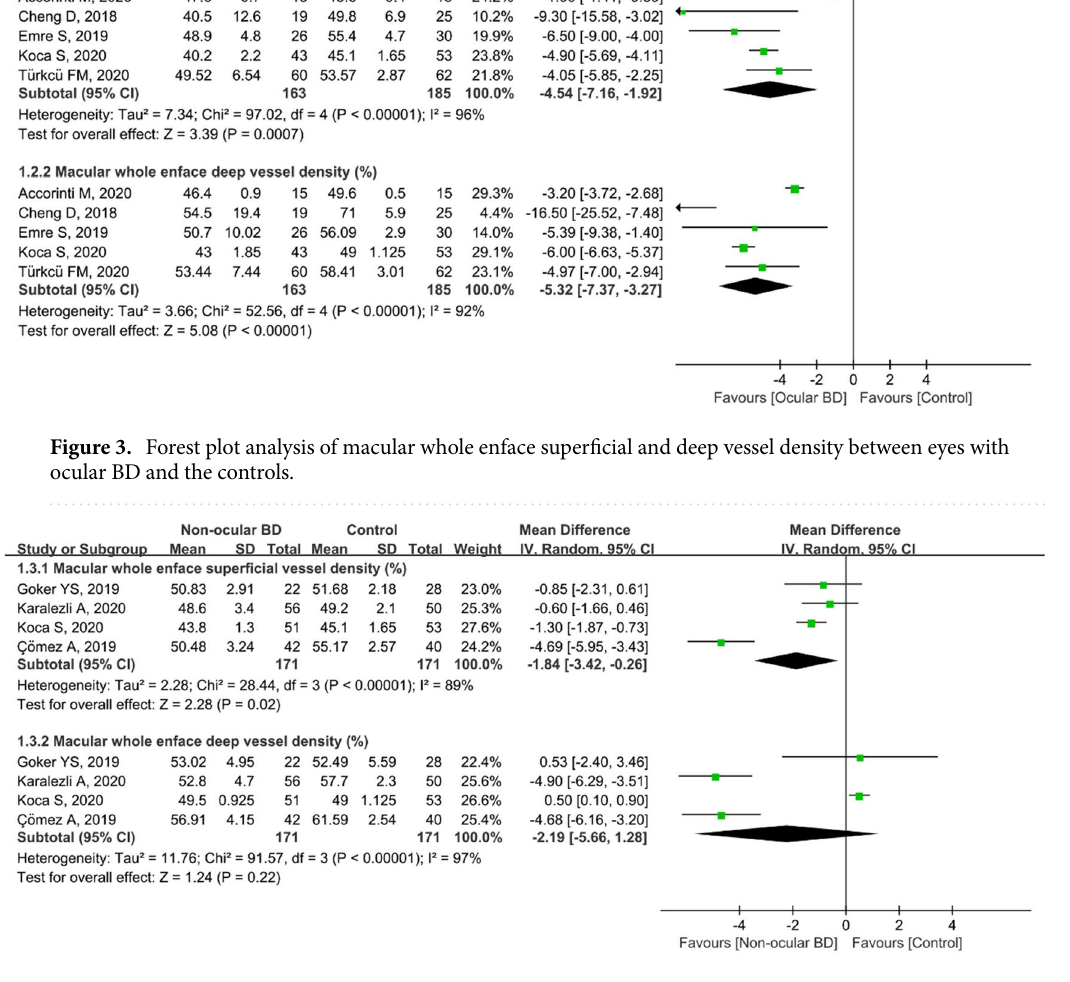
Figure 4. Forest plot analysis of macular whole enface superficial and deep vessel density in non-ocular BD patients and − 0.11, P = 0.04; Fig. 7), and there was no heterogeneity among the studies for this parameter (chi 2 = 1.48, P = 0.48, I 2 = 0%; Fig. 7). The summary MD for foveal deep VD was significantly lower in non-ocular BD participants than in controls (MD: − 6.09, 95%CI: − 11.91 to − 0.27, P = 0.04; Fig. 7); however, there was high heterogeneity across the studies (chi 2 = 16.11, P = 0.0003, I 2 = 88%; Fig. 7). Parafoveal VD in patients with BD and controls. Regarding parafoveal VD, 923 eyes (443 eyes in the BD group and 480 eyes in the control group) in nine studies were included in the analysis. The pooled results for parafoveal superficial VD (MD: − 3.68, 95%CI: − 5.05 to − 2.30, P < 0.00001; Fig. 8) and deep VD (MD: − 4.95, 95%CI: − 7.80 to − 2.09, P = 0.0007; Fig. 8) were significantly lower in the BD group than in the control group, with high heterogeneity across studies (superficial VD: chi 2 = 173.86, P < 0.00001, I 2 = 94; deep VD: chi 2 = 600.56, P < 0.00001, I 2 = 98%; Fig. 8). Subgroup analyses in six studies revealed that pooled results for parafoveal super- ficial VD (MD: − 5.83, 95%CI: − 7.60 to − 4.07, P < 0.00001) and deep VD (MD: − 7.65, 95%CI: − 10.09 to − 5.22, P < 0.00001) were significantly lower in ocular BD patients than in controls (Fig. 9), and these studies had high heterogeneity (superficial VD: chi 2 = 53.41, P < 0.00001, I 2 = 91%; deep VD: chi 2 = 59.46, P < 0.00001, I 2 = 92%) (Fig. 9). In addition, five studies including 355 eyes (172 eyes in the non-ocular BD group and 183 eyes in the control group) compared the parafoveal superficial VD between the groups. The difference was significant between the two groups (MD = − 1.28, 95% CI: − 2.18 to − 0.37, P = 0.006; Fig. 10), and there was moderate heterogeneity across the studies (chi 2 = 7.94, P = 0.09, I 2 = 50%; Fig. 10). The pooled result for parafoveal deep VD revealed sub- stantial heterogeneity (chi 2 = 49.71, P < 0.00001, I 2 = 92%; Fig. 10), and parafoveal deep VD was lower in eyes with non-ocular BD, although the difference was not significant (MD: − 1.57, 95%CI: − 3.84 to 0.69, P = 0.17; Fig. 10).